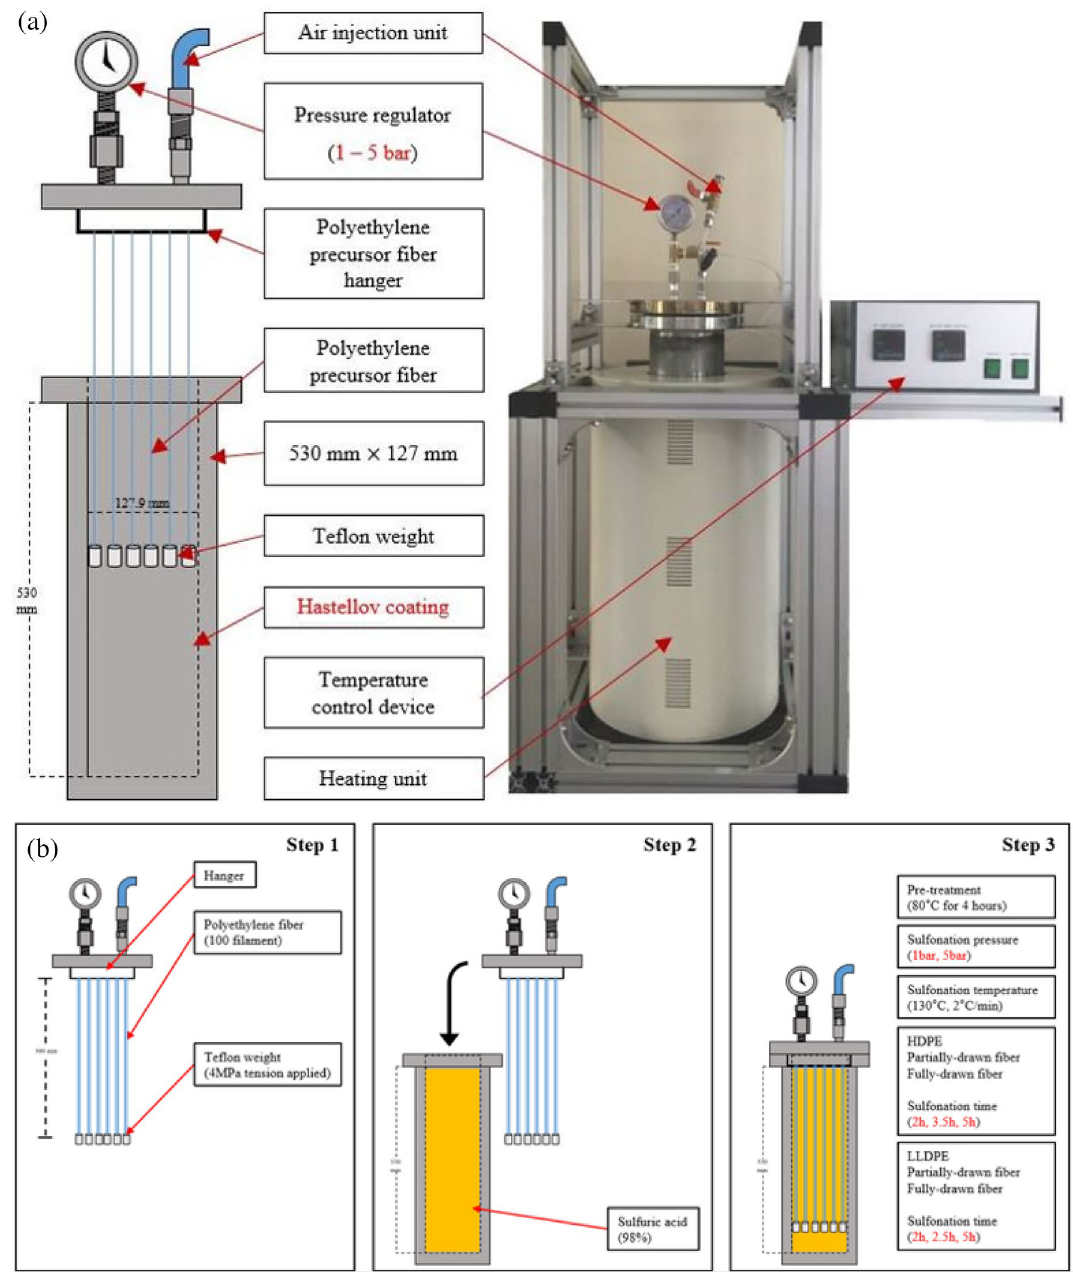
Figure 1. Schematic diagram of the sulfonation equipment and hydrostatic sulfonation process ( a ) A self- designed sulfonation equipment, ( b ) Schematic diagram of the hydrostatic sulfonation